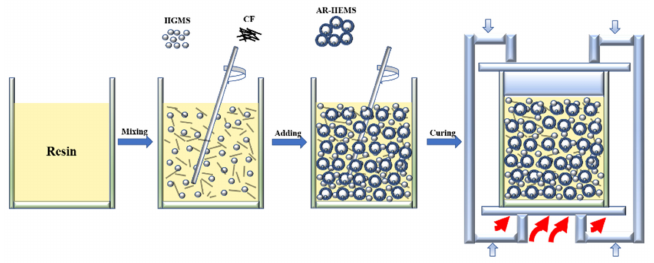
Figure 2. The schematic diagram of the preparation of the ESF.